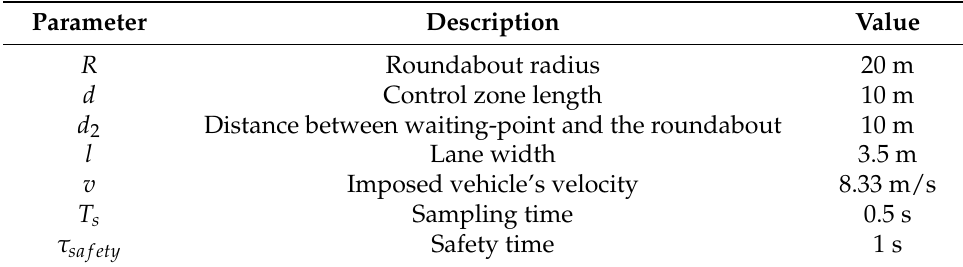
Table 1. Roundabout parameters.